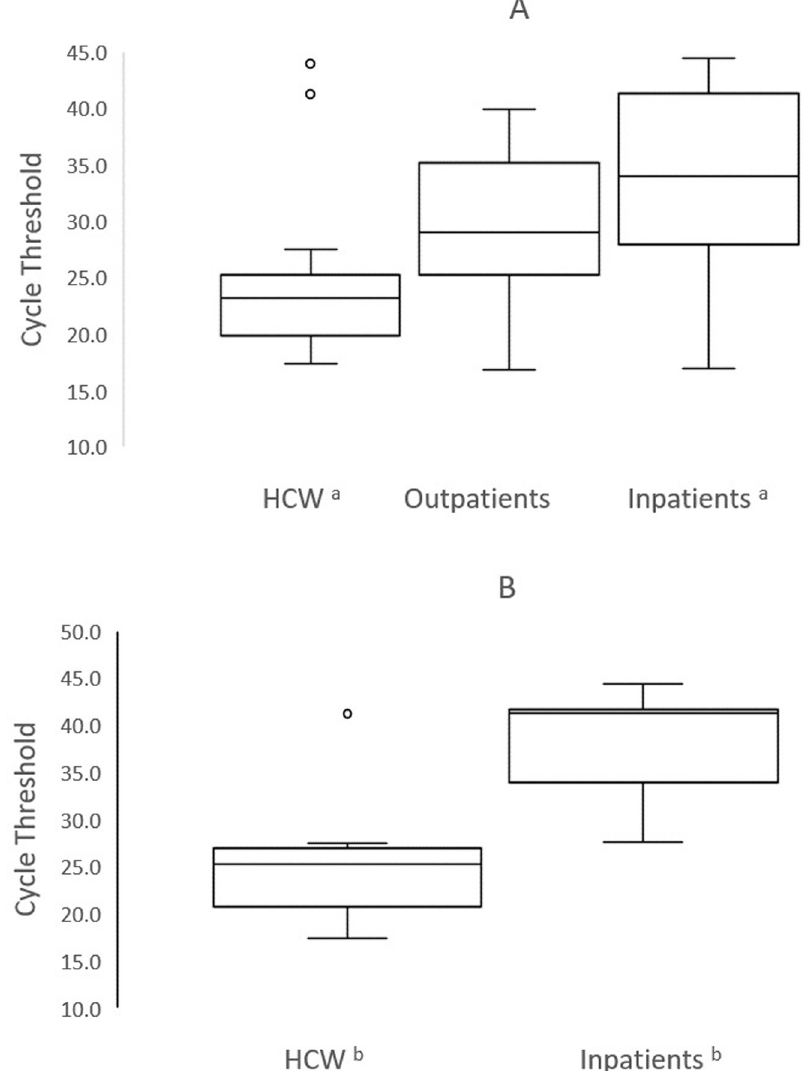
Fig 1. Comparison of the cycle threshold values of healthcare workers (HCW), outpatients, and inpatients with a positive RT-PCR SARS-CoV-2 test. A, All individuals a p = 0.003. B, Asymptomatic individuals b p = 0.001. Midlines indicate the median, boxes indicate interquartile ranges, whiskers indicate the upper and lower adjacent values (within 1.5-fold the interquartile range), and isolated data points indicate outliers.